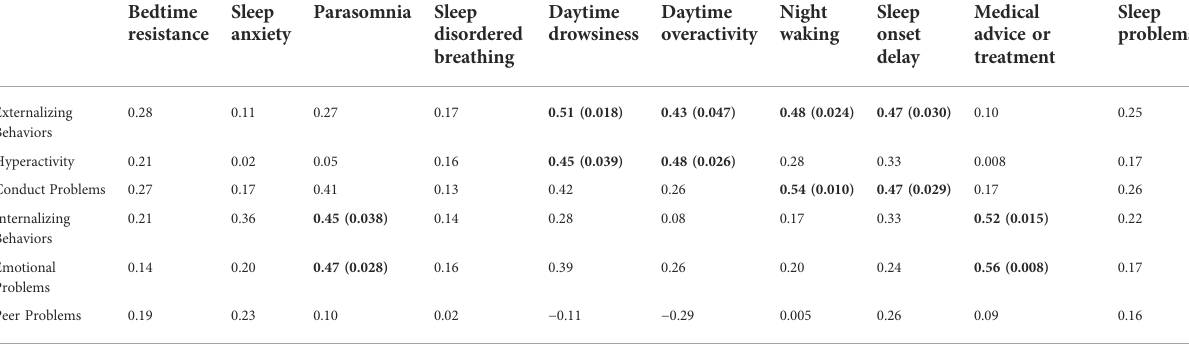
TABLE 5 Bivariate correlations between sleep features and problem behaviors while controlling for age ( N =